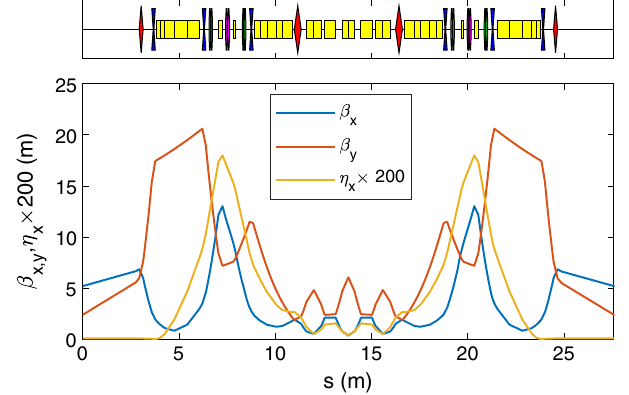
FIG. 4. Linear lattice functions for a sector of the APS-U lattice.